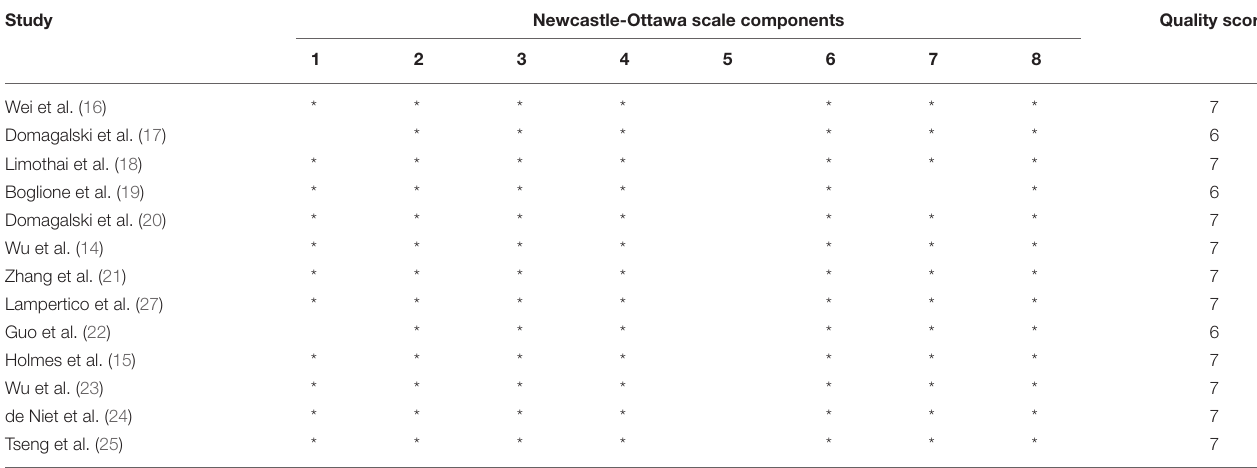
TABLE 2 | The quality assessment of included studies by the Newcastle-Ottawa Scale. Study